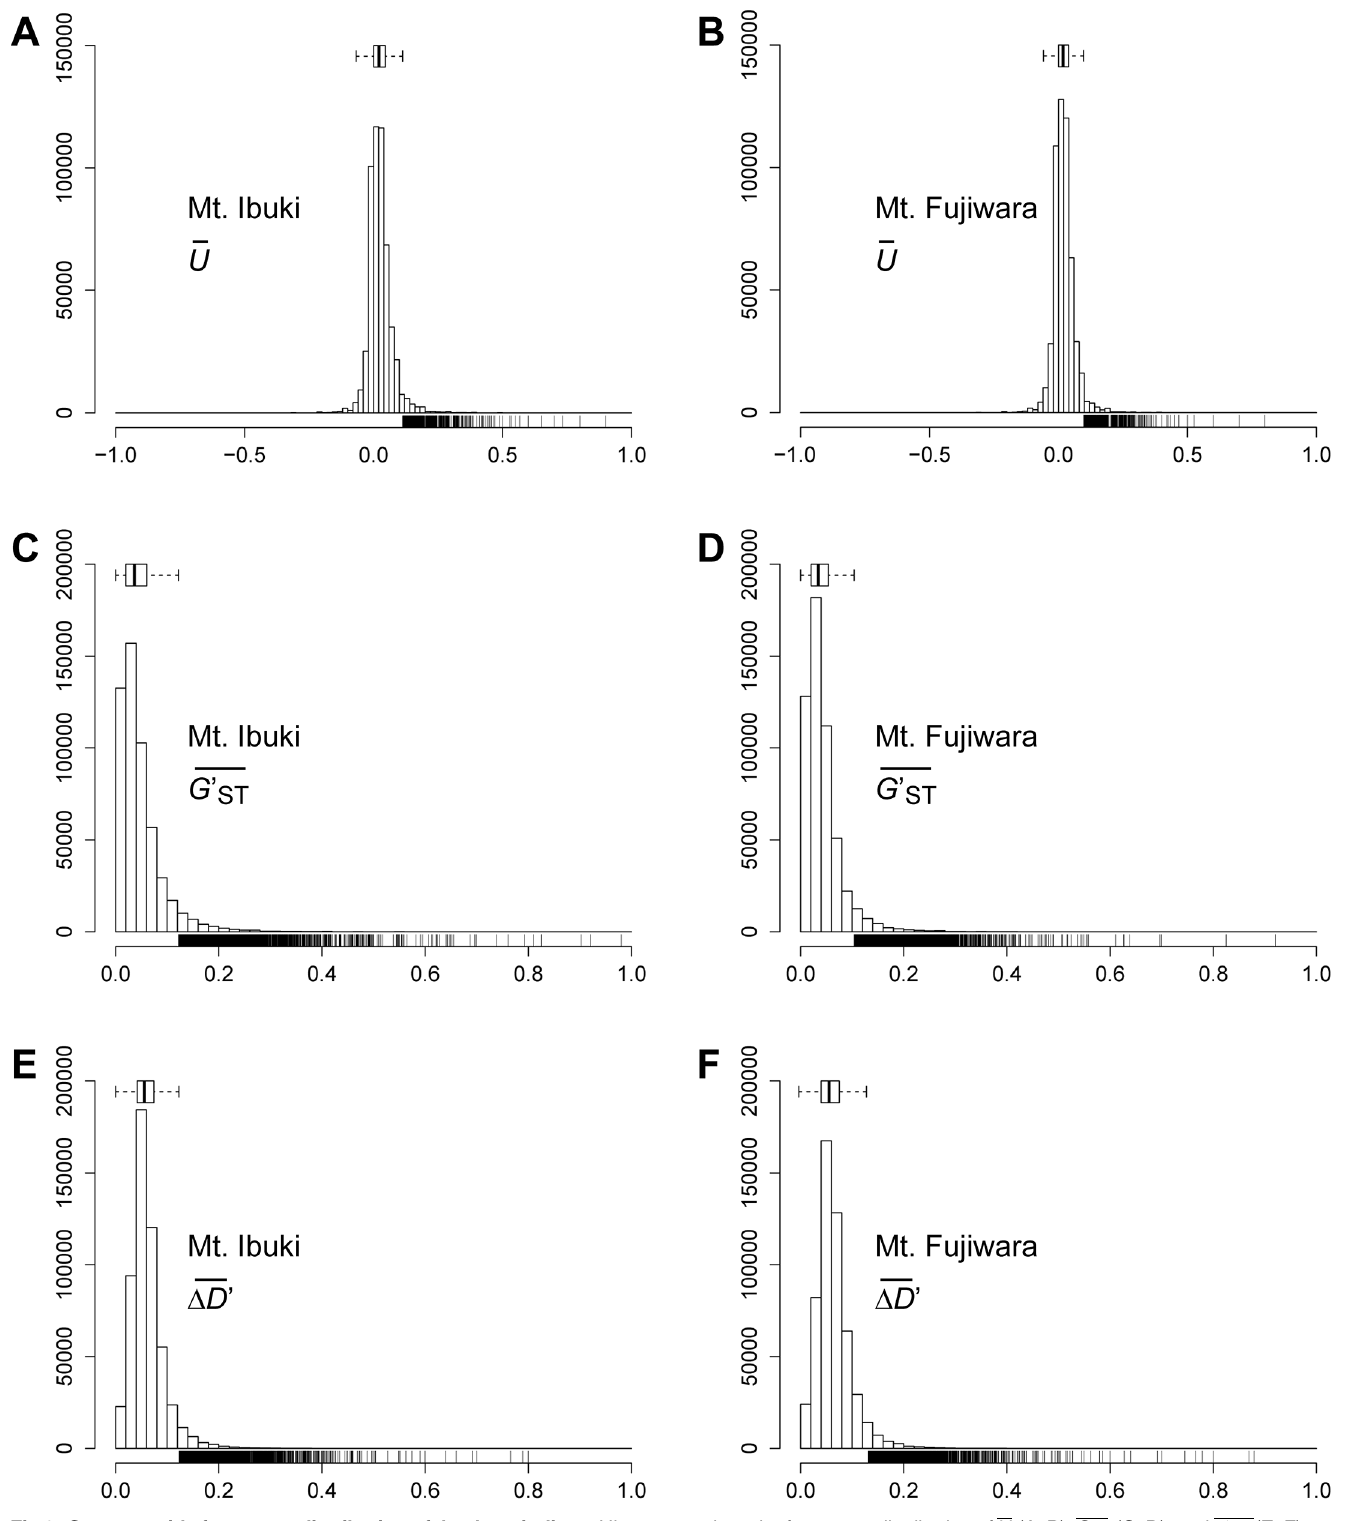
(C, D), and D D 0 (E, F) ST